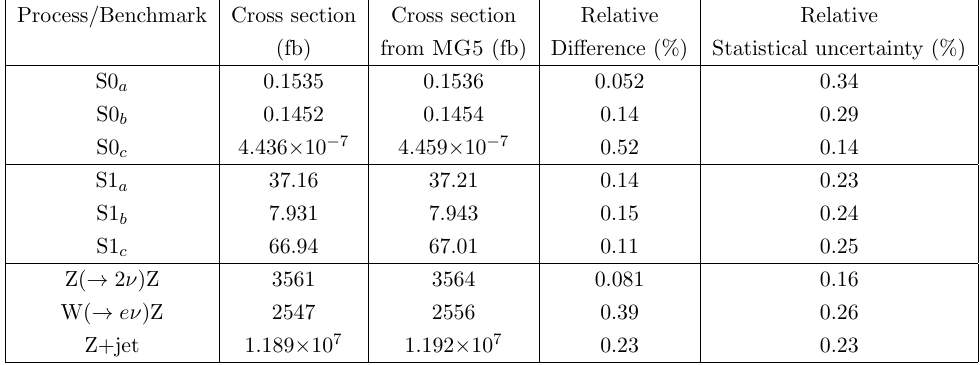
Table 7 . Comparison of cross sections obtained by our program and the MG5 , with one on-shell Z boson in the (cid:12)nal states. Their di(cid:11)erences and the statistical uncertainties taken from the MG5 are presented relative to the MG5